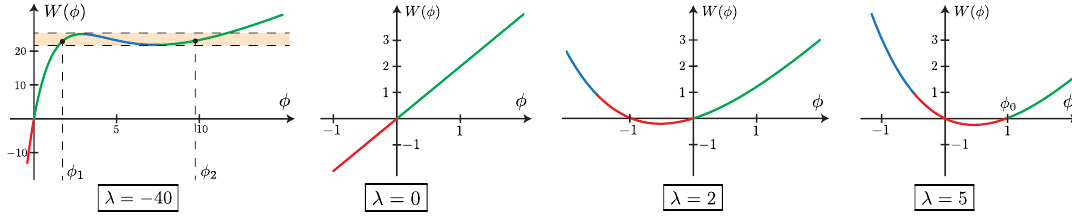
Figure 2. Deformed JT gravity dilaton potential W ( φ ) = 2 φ + U ( φ ) in equation (3.1) for the values ( α 1 , α 2 ) = (0 . 9 , 0 . 95) and several values of λ . Segments of the curve in red, blue and green indicate whether the black hole solution with φ h = φ is nonexistent (violates (3.4)), unstable (negative specific heat) or stable (positive specific